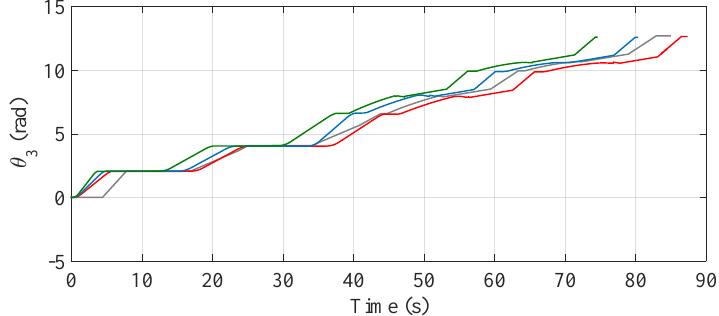
Figure 24. Behavior of the angular position of the driving wheels ( θ 3 ) when the optimization is carried out with α = 0 ( — ), α = 0.5 ( — ) and α = 1 ( — ) and when the optimization is not considered ( — ).